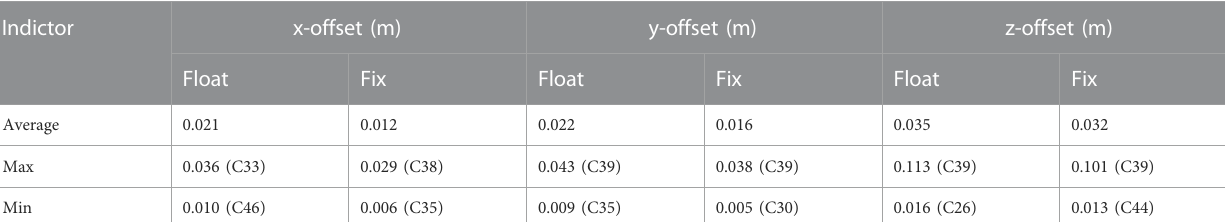
TABLE 4 Statistical STD values for the estimated ISL ’ s